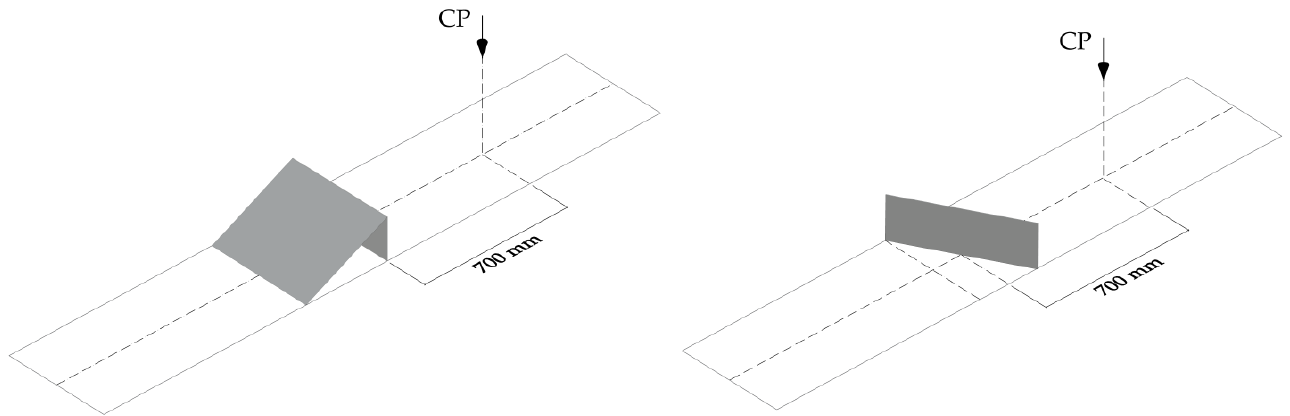
Figure 6. Location of the control point (CP) used in the comparisons. Weir 4 ( left ) and Weir 5 ( right ).